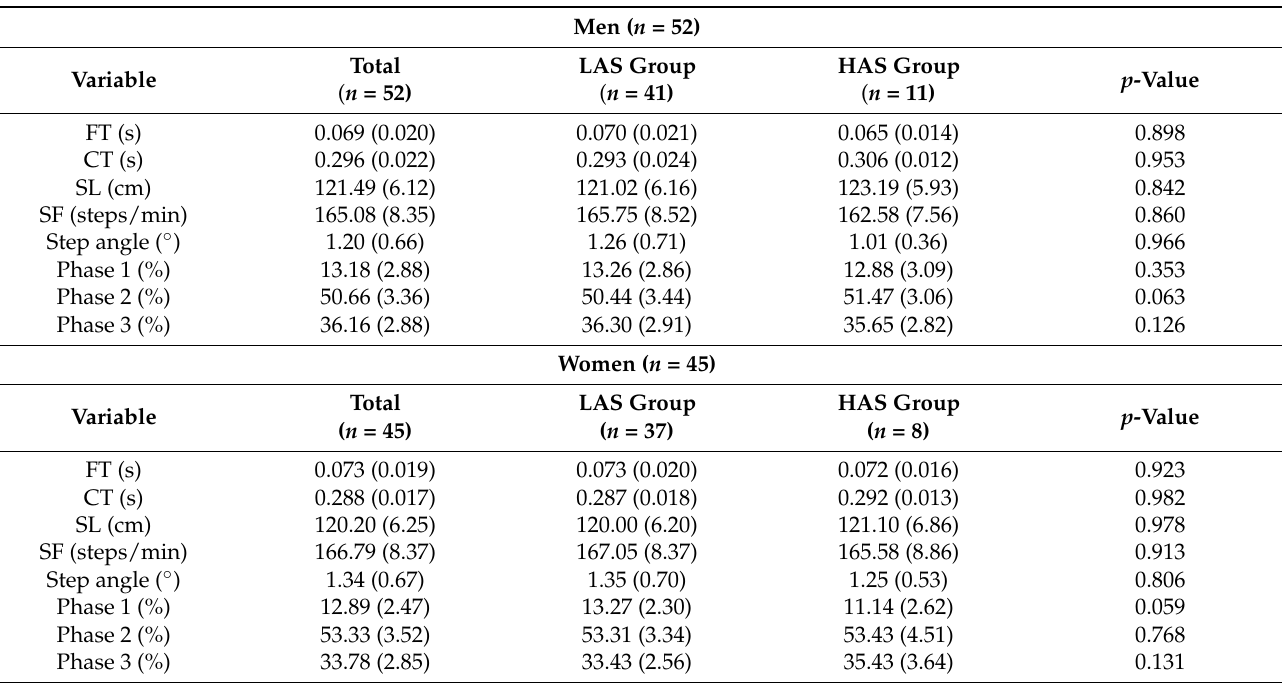
Table 4. Spatiotemporal variables during running at 12 km · h − 1 according to the created subgroups (LAS vs. HAS), for both men and